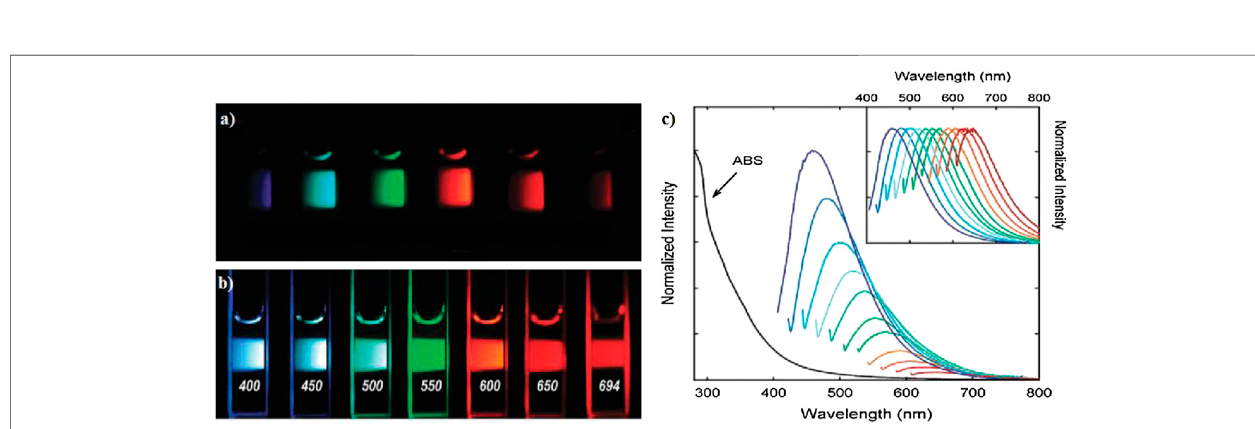
FIGURE10| Aqueous solutionofthePEG-CQDs: (A) excited at 400 nm and photographed throughbandpass fi ltersofdifferentwavelengthsasindicatedand (B) excited at the indicated wavelengths and photographed directly. (C) Absorbance (ABS) and luminescence emission spectra (with progressively longer excitation wavelengths from 400 nm on the left in 20 nm increment) of propionylethyleneimine-co-ethyleneimine (PPEI-EI) CQDs in an aqueous solution. The emission spectral intensities are normalized to quantum yields (inset: normalized to spectral peaks). Reprinted with permission from Sun et al. (2006).